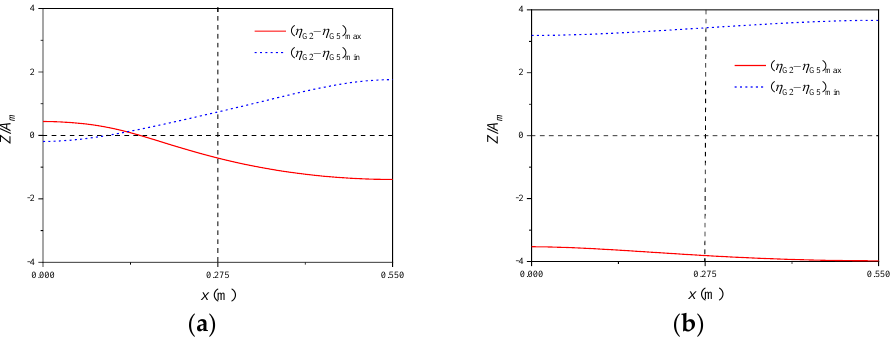
Figure 13. Free surface elevation profiles in the chamber. ( a ) k p h = 3.010, ( b ) k p h = 0.750.